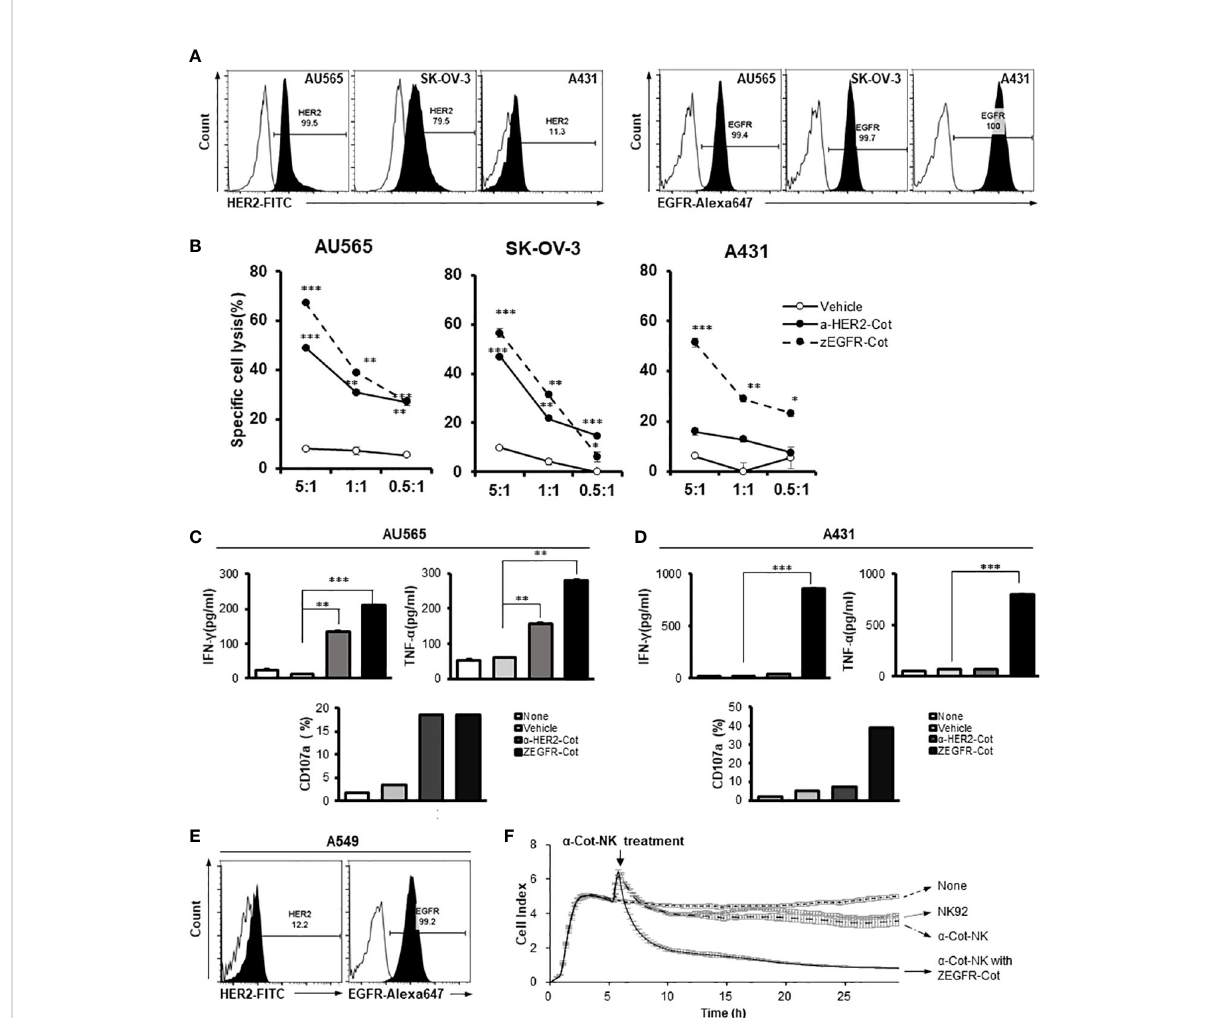
FIGURE 2 The action of a -Cot-NK92 cells depends on the type of conjugator. (A) Expression levels of HER2 and EGFR in various tumor cell lines, including mammary gland adenocarcinoma (AU565), ovarian adenocarcinoma (SK-OV-3), and epidermoid carcinoma (A431), were con fi rmed through FACS. Histograms are representative of at least three independent experiments. (B) Cytotoxicity against HER2 + , EGFR + , or HER2 + and EGFR + tumor cells mediated by a -Cot-NK92 cells with or without a -HER2-Cot or ZEGFR-Cot. The a -Cot-NK92 cells were co-cultured with calcein-stained tumor cells with or without a conjugator for 4 h at E:T ratios of 5:1, 1:1, and 0.5:1. The intensity of fl uorescence emitted from the lysed target cells was measured using a fl uorescence plate reader (SpectraMax i3x). All cytotoxicity data are represented as the mean ± S.D. of triplicate experiments. The statistical signi fi cance of differences between groups was evaluated using paired Student ’ s t- test. *** P < 0.001; ** P < 0.01; * P < 0.05 vs. vehicle; ns: not signi fi cant. (C, D) IFN- g and TNF- a secretion and CD107a expression in a -Cot-NK92 cells cultured with or without HER2 + EGFR + AU565 (C) or HER2 − EGFR + A431 (D) cells and with/without the conjugator ( a -HER2-Cot or ZEGFR-Cot). Secreted IFN- g and TNF- a levels were measured via ELISA using the medium of a -Cot-NK92 cells co-cultured with target cells at a 1:1 E:T ratio for 12 h. All experiments were performed in triplicate wells for each condition and repeated at least two times. Average values are shown as the mean ± S.D. of triplicates. Statistical signi fi cance of differences between groups was evaluated using paired Student ’ s t -test. *** P < 0.001; ** P < 0.01; ns: not signi fi cant. CD107a expression in a -Cot-NK92 cells was evaluated through FACS analysis after co-culture with target cells at a 5:1 E:T ratio for 4 h. Each value represents the percentage of CD56 + CD107a + cells in fl ow cytometric density plots. (E) Expression level of HER2 and EGFR in pulmonary adenocarcinoma (A549) con fi rmed through FACS analysis. Histograms are representative of at least three independent experiments. (F) Kinetics of a -Cot-NK92 cell-mediated tumor cell lysis using the xCELLigence real time cell analysis system. NK92 or a -Cot-NK92 cells were co-cultured with unlabeled A549 cells with/without ZEGFR-Cot at a 5:1 E:T ratio and monitored over time. CAR, chimeric antigen receptor; Cot, cotinine; NK, natural